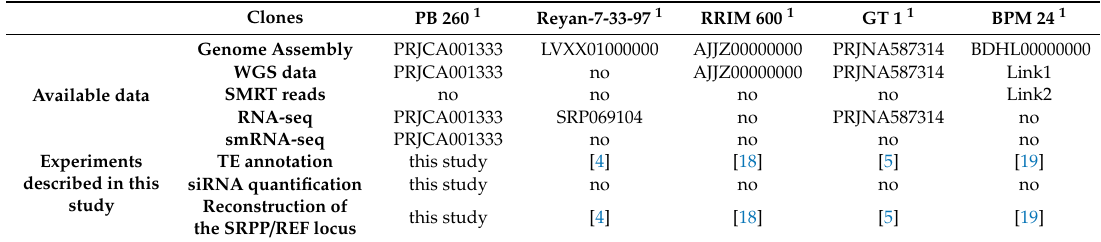
Table 4. Overview of genome assembly available and used in this